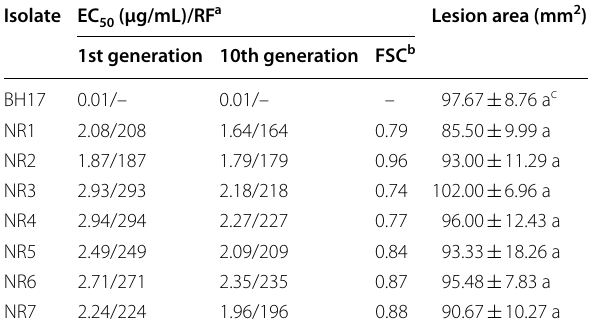
Table 2 Resistance stability and pathogenicity of the ZJ0712- resistant Podosphaera xanthii isolates